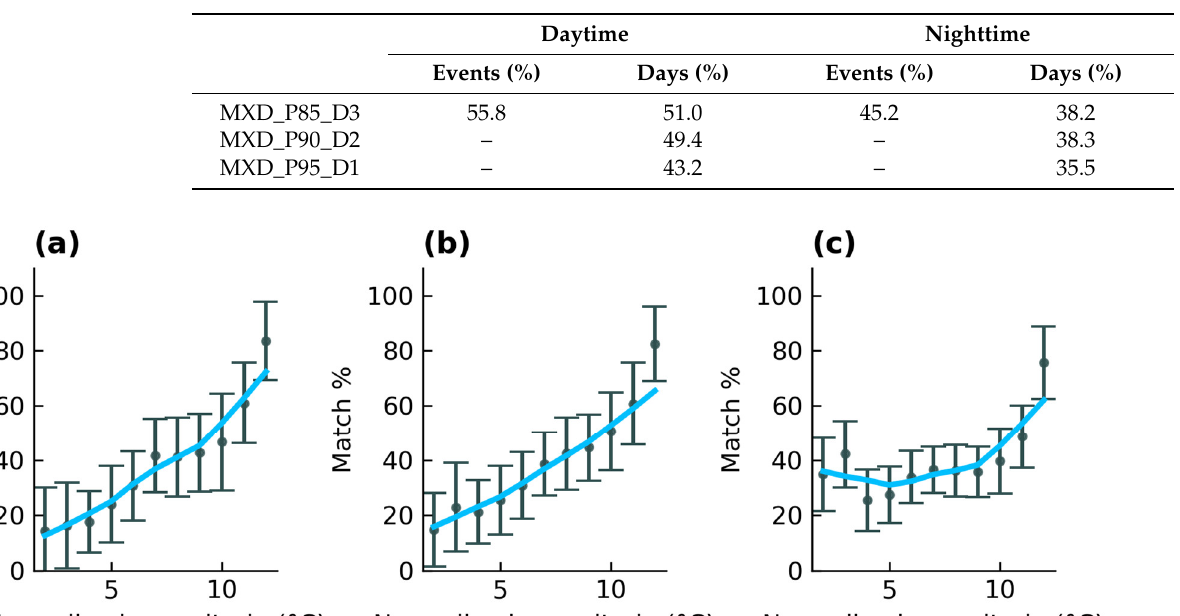
Table 3. Overall match percentage corresponding to the percent of LST anomalies events and days that coincide with heatwaves.